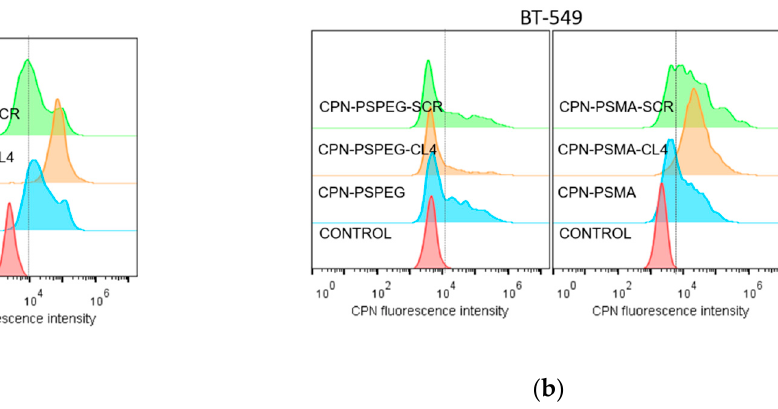
Figure 3. Flow cytometry assay to evaluate binding ability of aptamer-decorated CPN in TNBC cell lines. Representative single-cell emission histograms for EGFR-positive TNBC MDA-MB-231 ( a ) and BT-549 ( b ) before (control, red) and after incubation (30 min) with CPN-PSPEG or CPN-PSMA conjugated with CL4 or SCR.